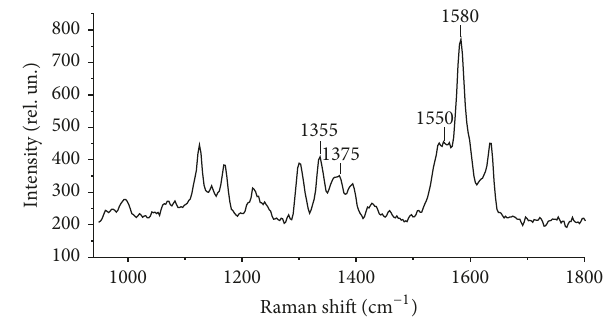
Figure 2: Spectrum of Raman scattering of hematoporphyrin hemoglobin. The figure shows the Raman bands with the position of the maximums of 1355, 1375, 1550, and 1580 cm −1 . The ordinate is the intensity of the Raman radiation, in conventional units; along the abscissa-frequency shift, cm −1